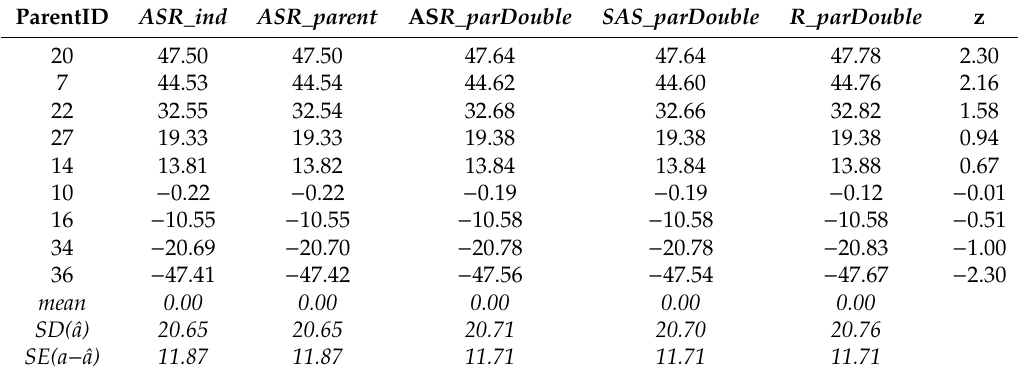
1 The analyses varied according to the software (ASREML, SAS Proc Mixed, or R lme4), linear model terms (individual tree or parent model), and / or the use of a normal or modified doubled dataset. 2 Standard error of prediction for each of the 40 parents was estimated directly by the software. 3 z-values based on breeding value (BV) predictions from model ASR_ind . For the full-sib SCA predictions ( ˆs ), the five di ff erent linear models produced nearly identical predictions for particular genotypes (Table 5). For any full-sib cross with a z-score more than 0.50, the predictions from the di ff erent linear models di ff ered only at the third significant figure. For example, for the full-sib family of female 28 × male 21, with a z-score = − 2.17 for the predicted SCA e ff ect, the predictions from the five linear models were ˆs 28_21 = − 6.92, − 6.91, − 6.86, − 6.83, and − 6.87 (female_male = 28_21 in Table